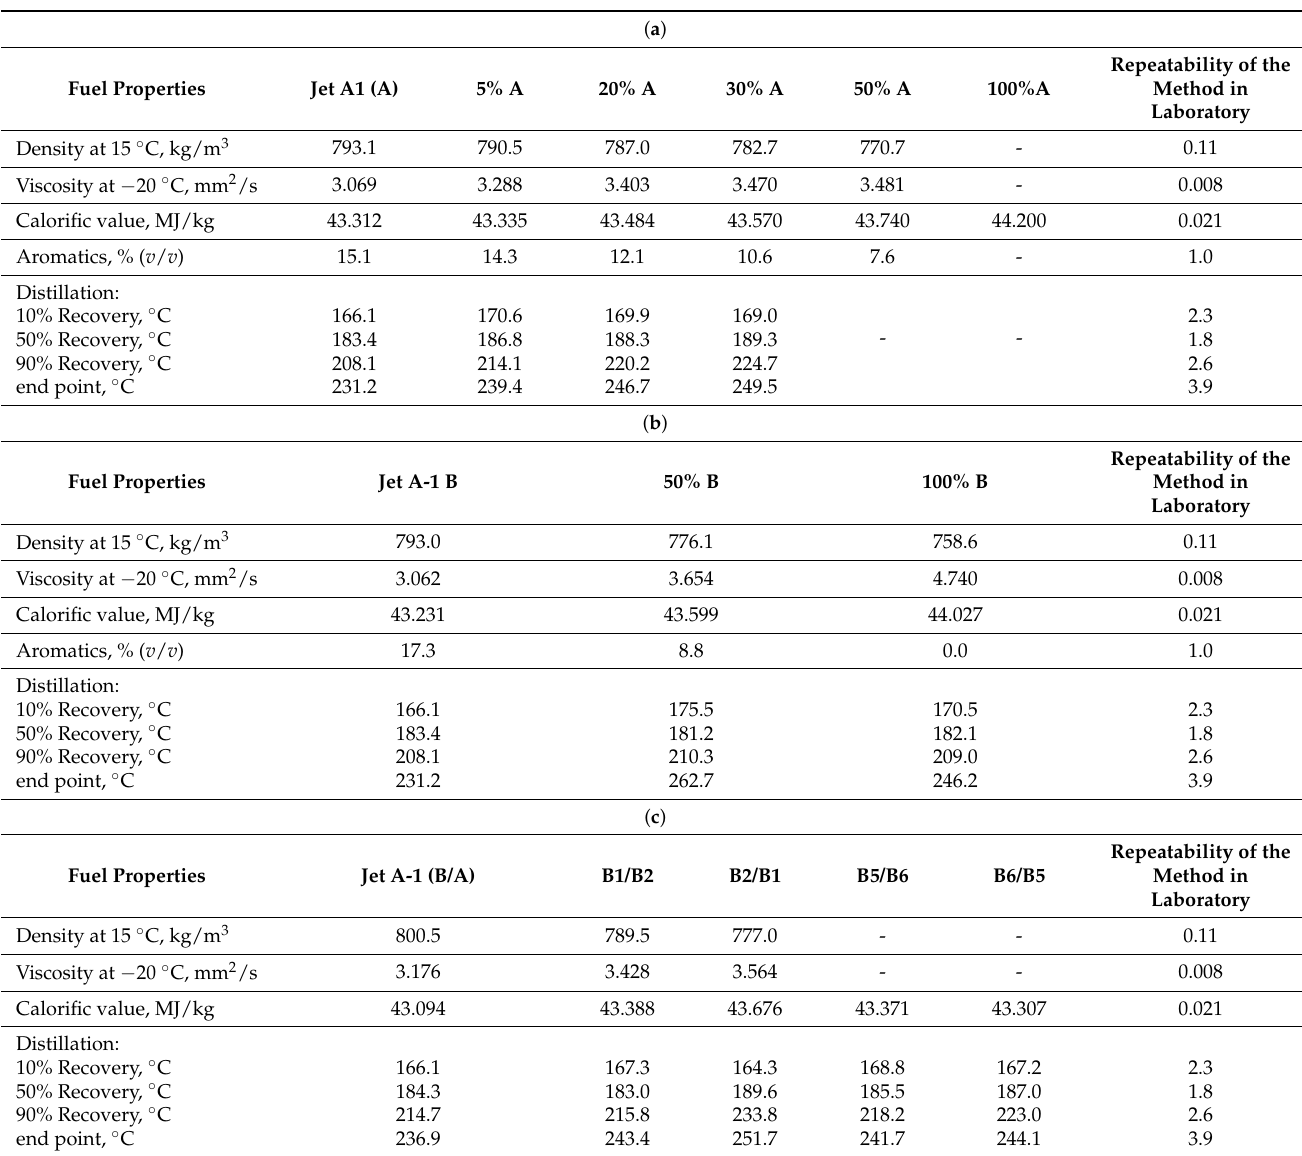
Table 2. Properties of tested fuels. ( a ) Synthetic component A; ( b ) synthetic component B; ( c ) blends containing synthetic components A and